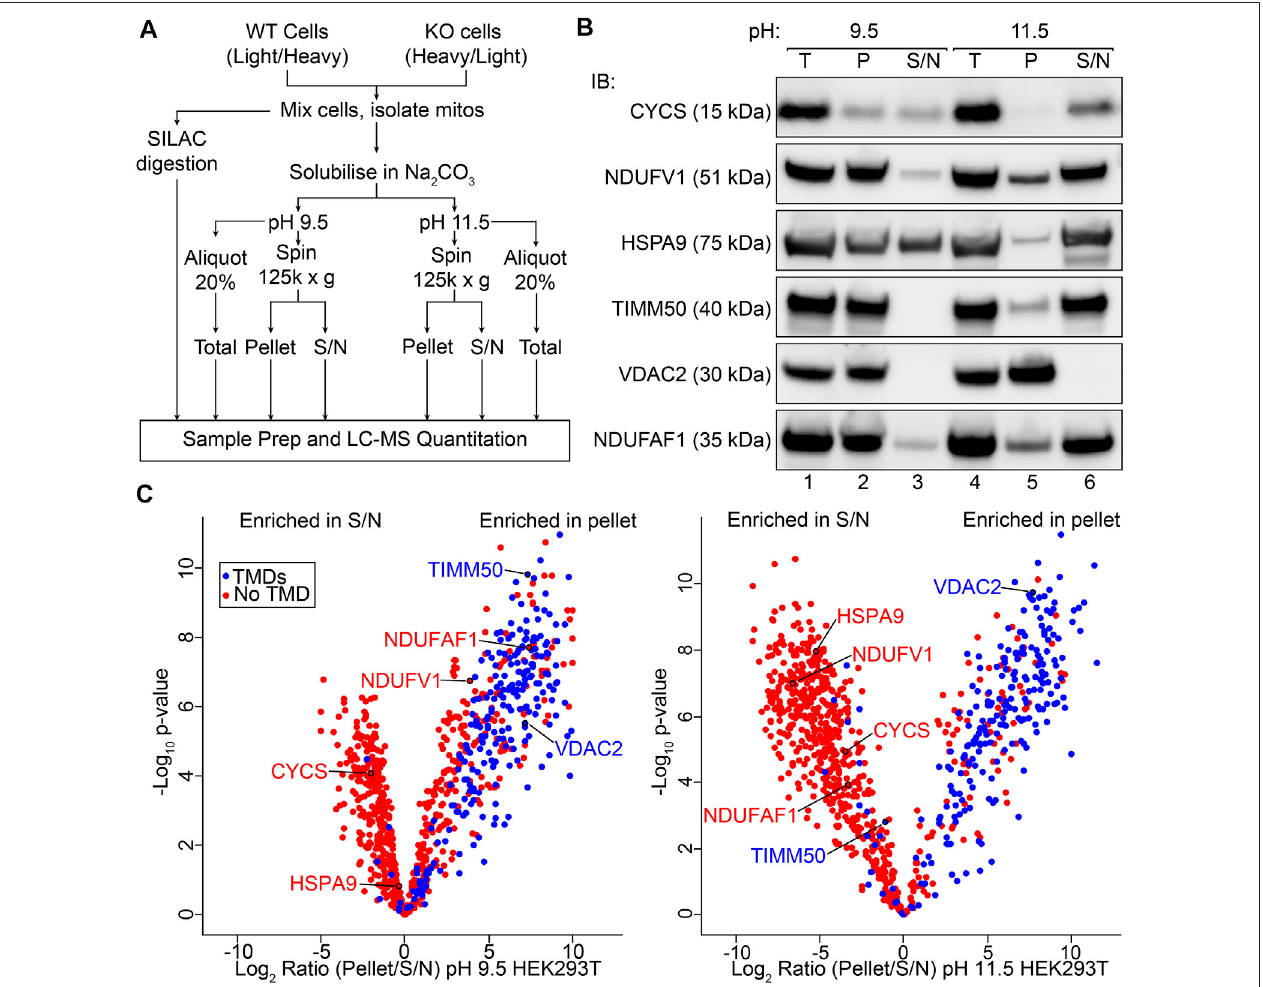
FIGURE 1 | Sodium carbonate extraction MS to assess membrane association on a mitochondrial proteome wide scale. (A) Protocol for SILAC coupled sodium carbonate extraction experiment. SILAC heavy and light labeled WT and KO cells are mixed and mitochondria isolated from the resultant pool of cells. Pooled mitochondria are then used directly for quantitative mass spectrometry or for sodium carbonate extraction (Na 2 CO 3 ) MS. Total, Pellet and Supernatant (S/N) fractions generated by carbonate extraction and analyzed by LC-MS. (B) Mitochondria isolated from the HEK293T cell line were subjected to sodium carbonate extraction and total (T), pellet (P) and supernatant (S/N) fractions were analyzed by SDS-PAGE and immunoblotting (IB) with indicated antibodies. (C) Volcano plots depicting relative abundance of mitochondrial proteins in the pellet and supernatant fractions after sodium carbonate extraction at pH 9.5 and 11.5.